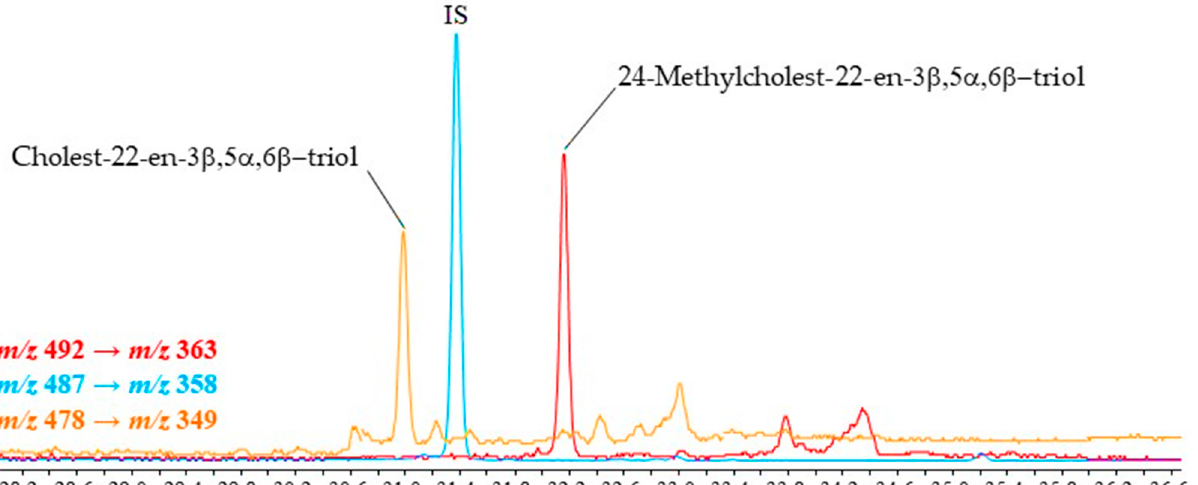
Table 5. Concentrations of unsaturated 3 β ,5 α ,6 β -steratriols in several environmental samples, measured after trifluoroacetylation in SIM and MRM modes.